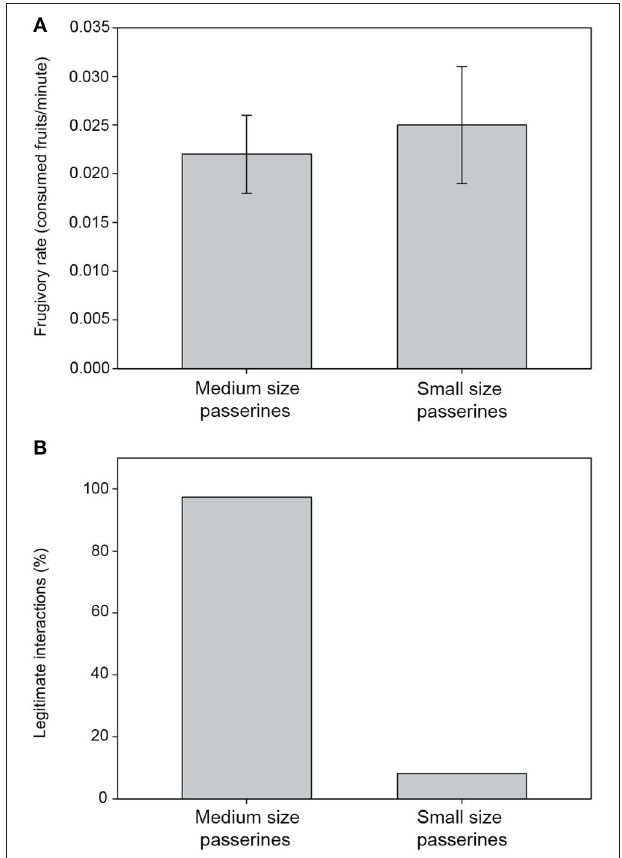
FIGURE 3 | Frugivory interactions involving passerine birds of different sizes were compared regarding interaction rate (A) , and their legitimacy as the proportion of interactions leading to actual seed dispersal (B) , regardless of whether digestive treatment occurred or not.